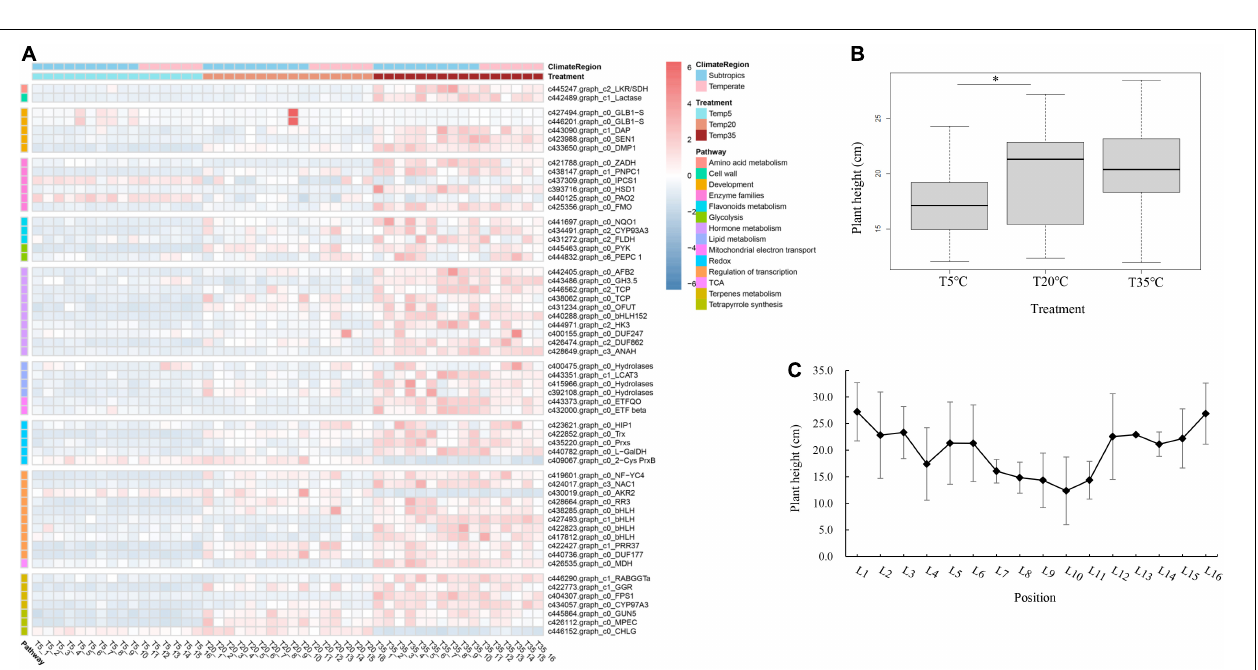
FIGURE 3 | Functional pathway of DEGs from weighted gene co-expression network analysis (WGCNA) modules with close relationship to quantitative traits. CHO, carbohydrates.